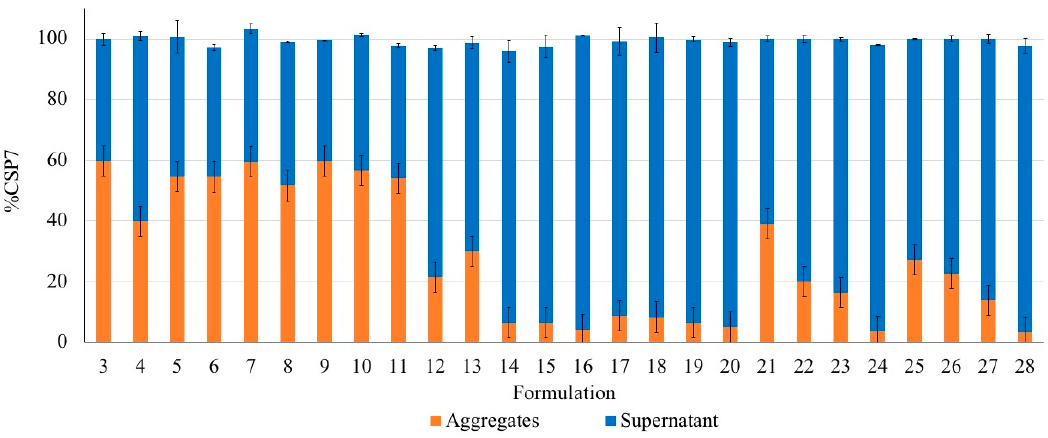
Figure 8. Recovery of CSP7 acetate in soluble aggregates and supernatant after exposure of the lyophilized CSP7 acetate formulations to 25 °C and 75% RH for 12 h.